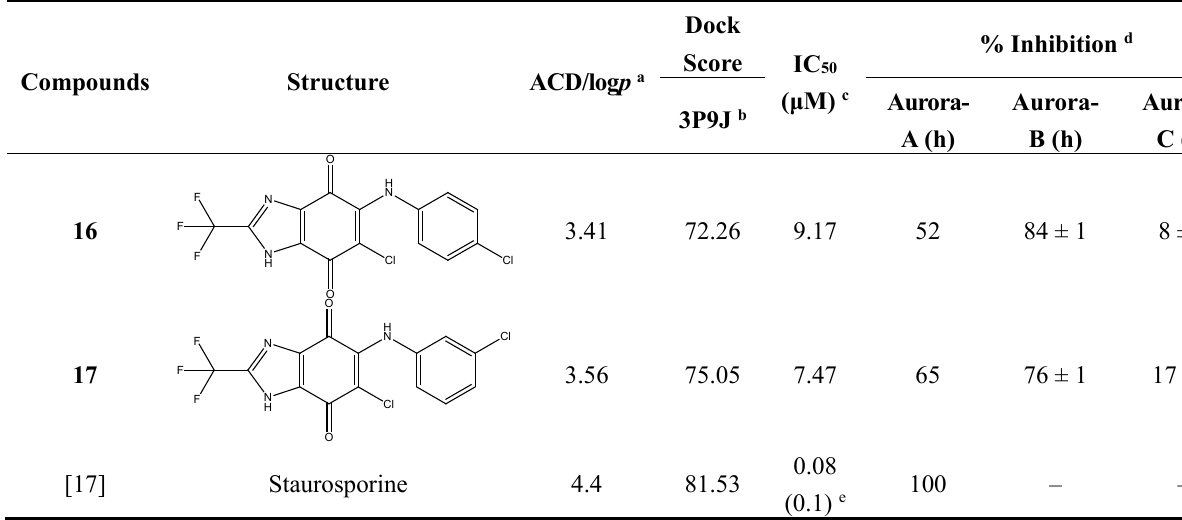
Table 3. The physicochemical properties, dockscores, and inhibition values of Aurora kinases by compound 16 and 17 .